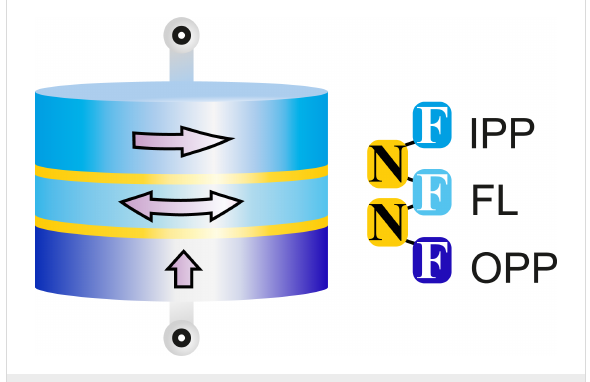
Figure 16: Sketch of an orthogonal spin transfer (OST) device. Arrows show magnetization directions in the device layers.